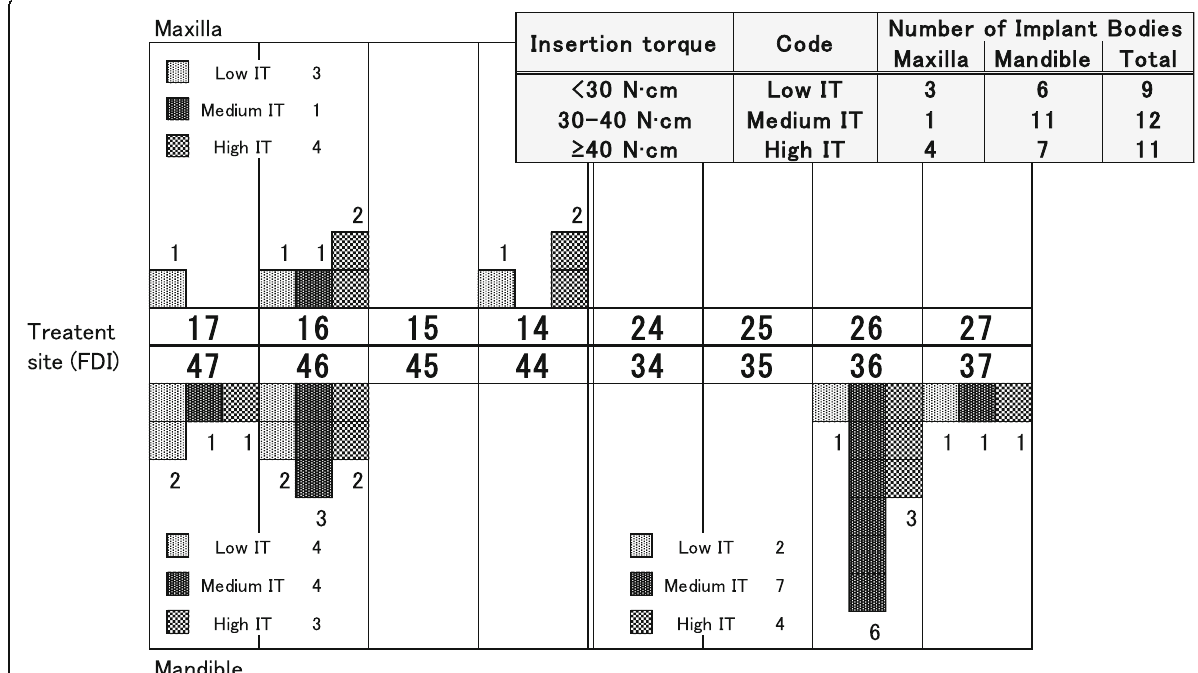
Fig. 4 The classification of the insertion torque. All specimens classified into three groups according to insertion torque. Criteria for the classification are shown in the figure and in the “ Methods ” section